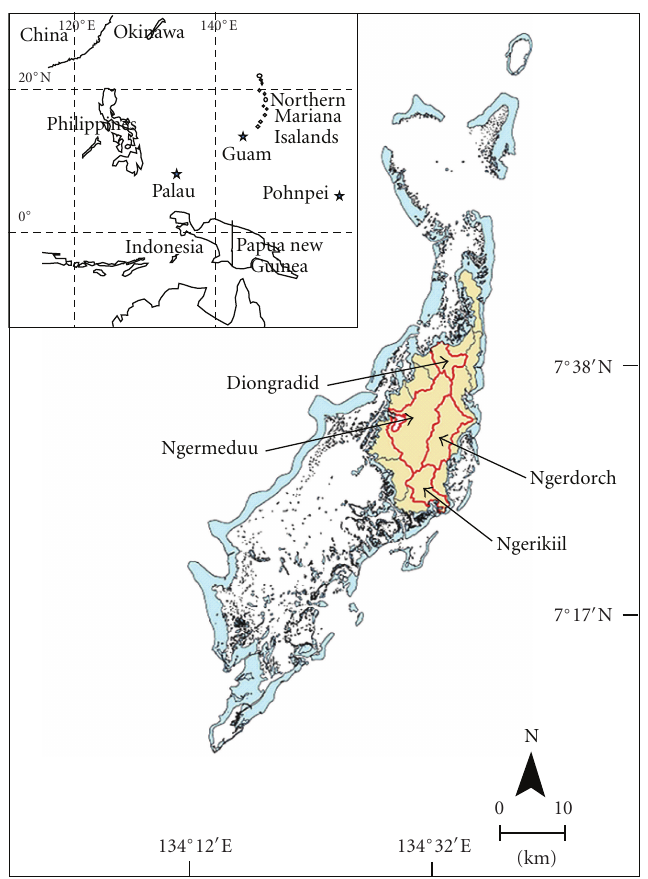
Figure 1: Map of region and Palau showing the four watersheds studied. Beige color indicate Babeldaob land area, blue indicates the reef area and the red lines mark the boundaries of the four watersheds